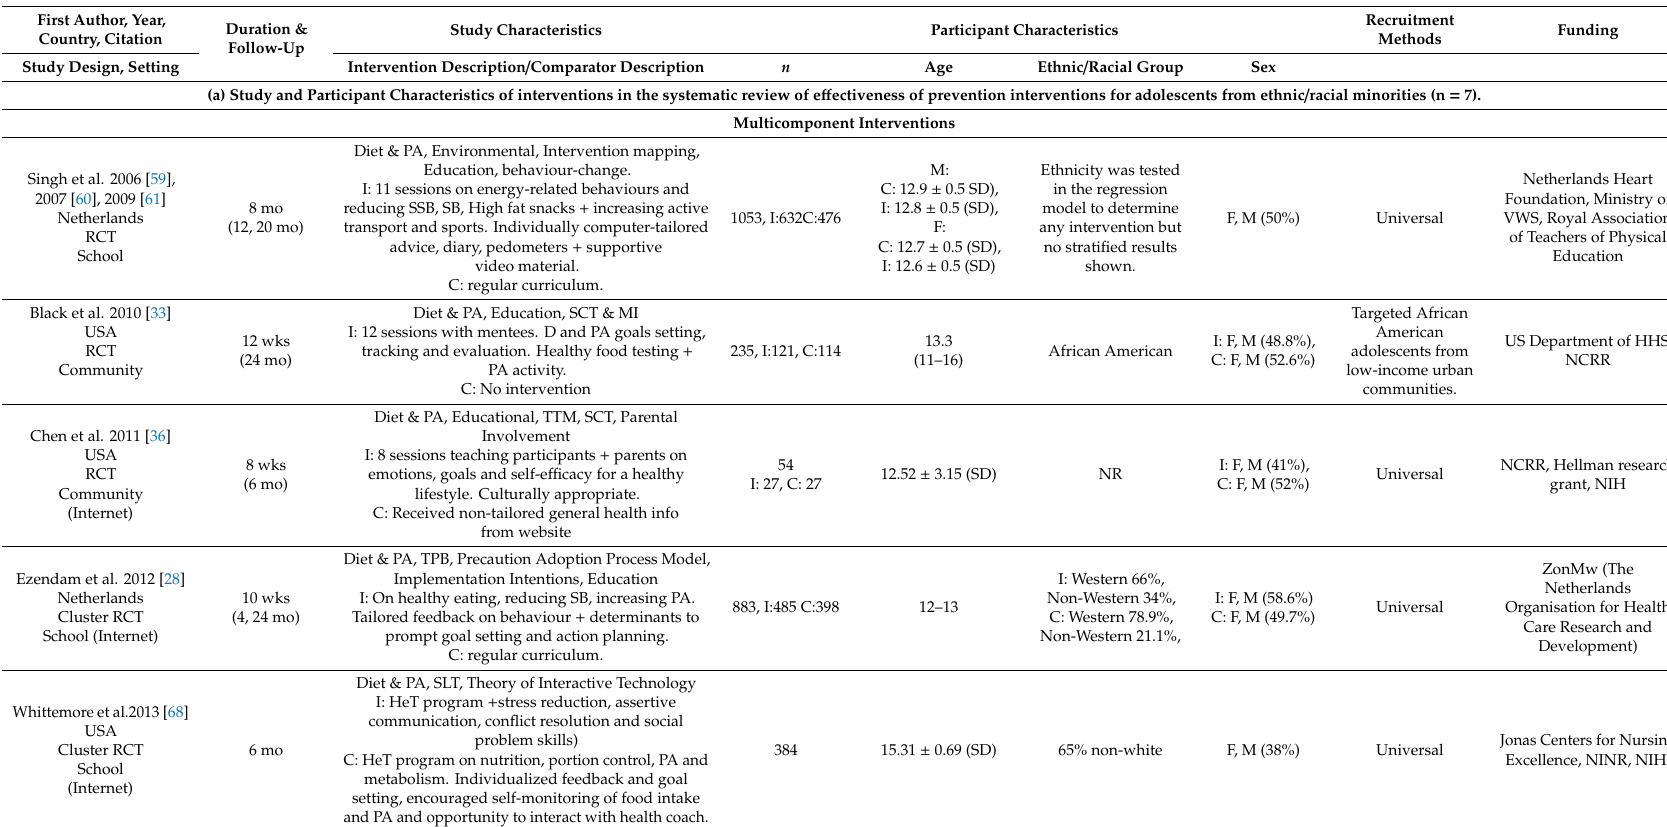
Table 1. Study and Participant Characteristics of interventions in the systematic review of e ff ectiveness of prevention interventions for adolescents from ethnic / racial